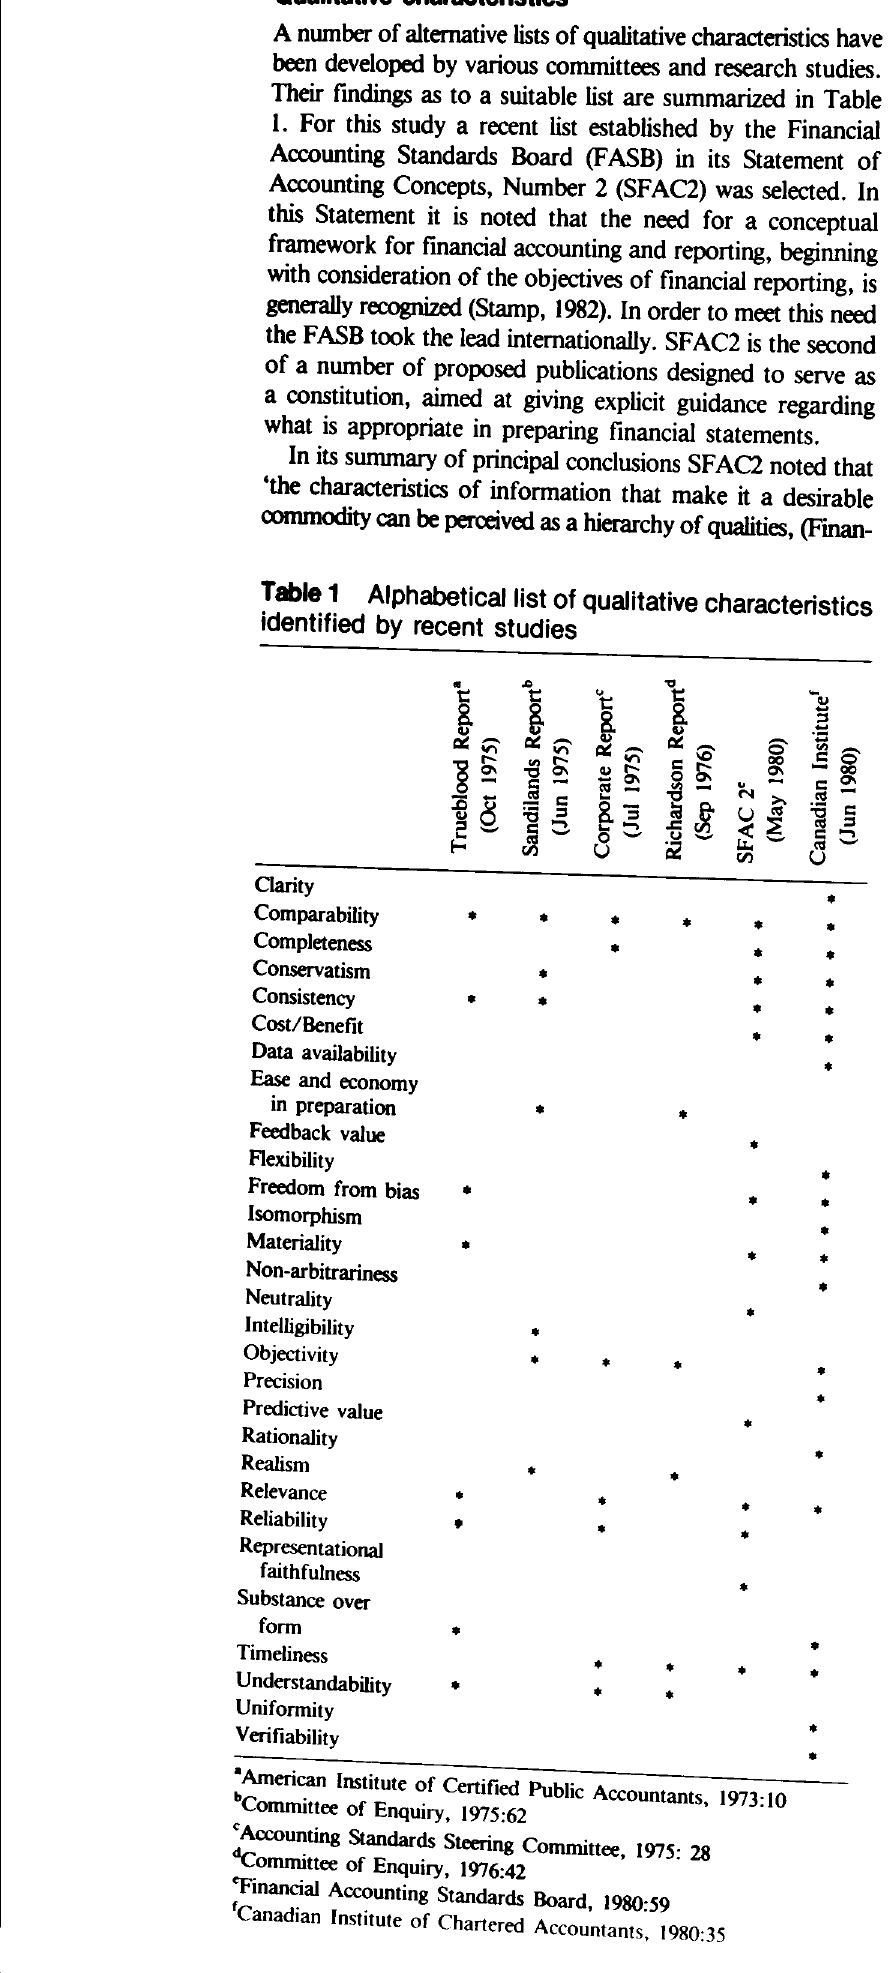
Alphabetical list of qualitative